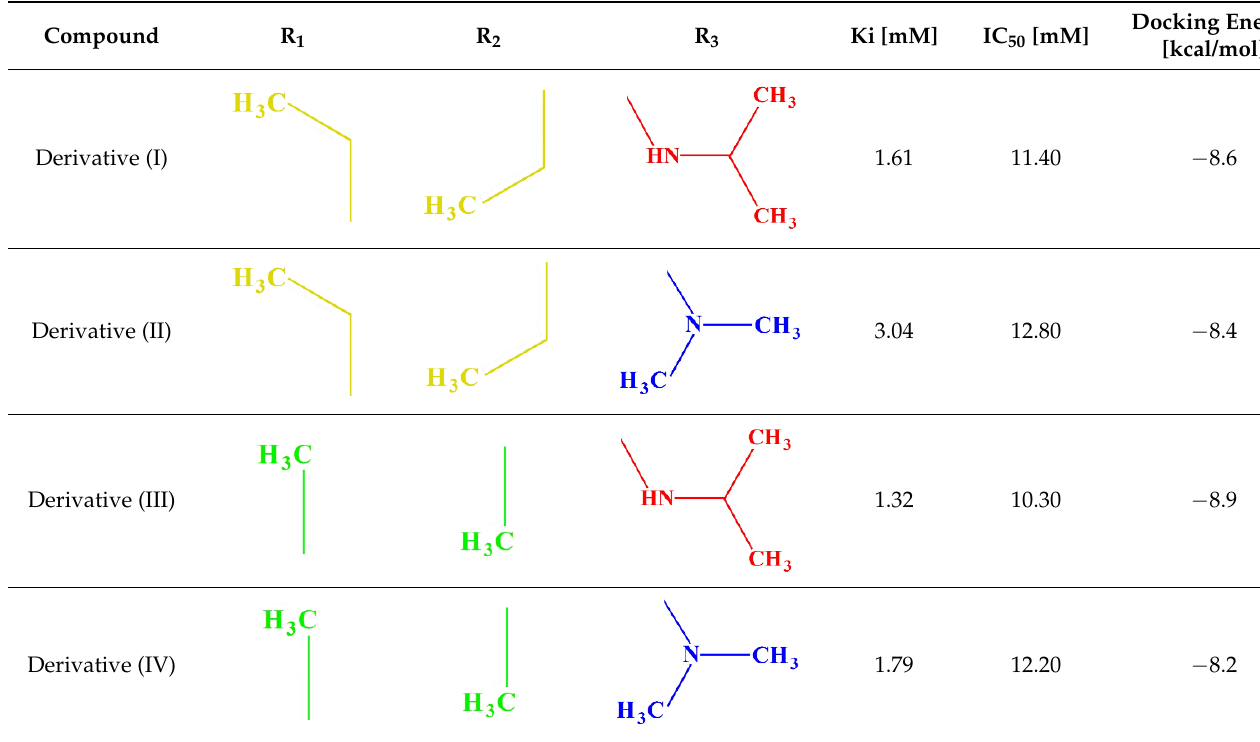
Table 5. Effect of the type of substituents occurring in the main structure of aminoalkanol derivatives